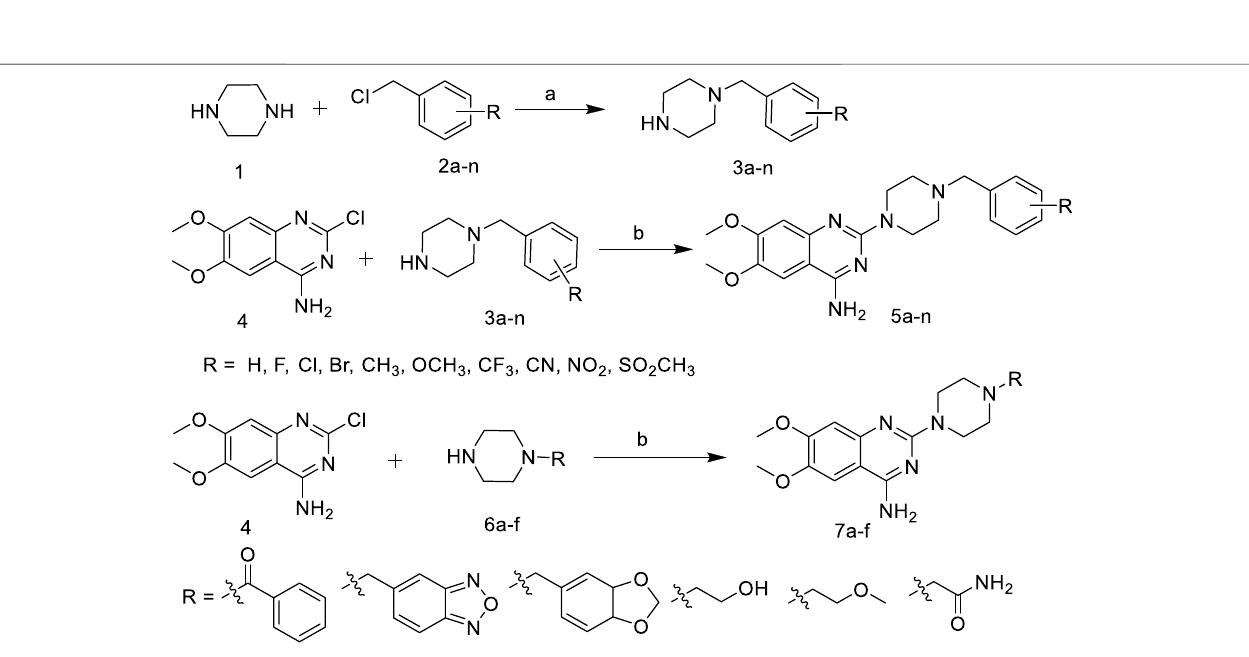
SCHEME 1 | Synthetic of target compounds 5a ~ n and 7a ~ f . Reagents and conditions: (a) CH 2 Cl 2 , r.t; (b) 1-R-piperazine, N 2 , 1-Pentanol, 135 ° C.